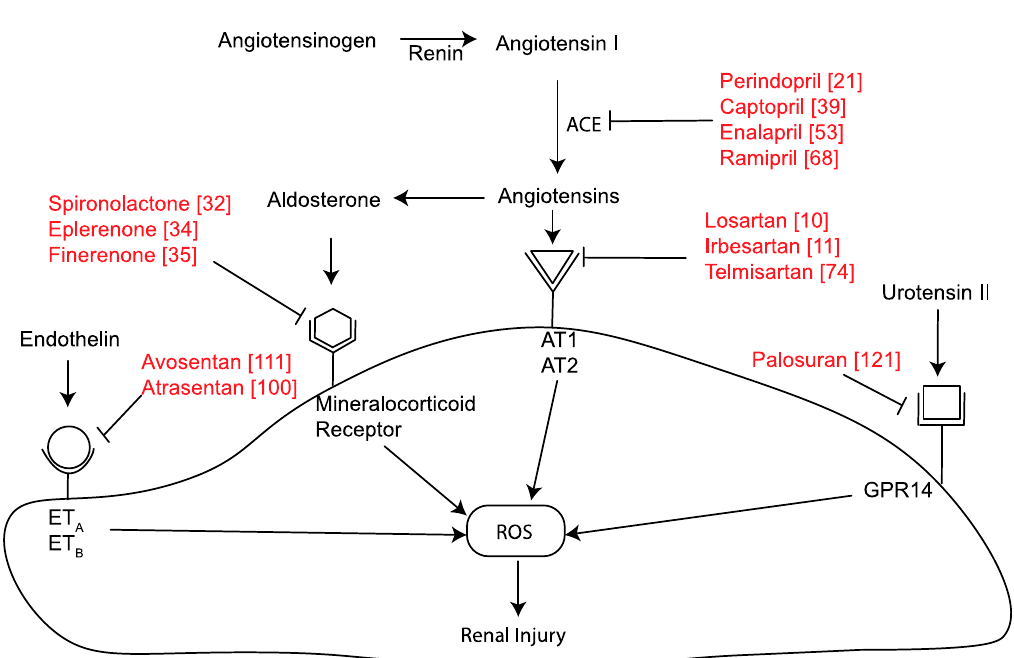
Figure 1. Role of vasoactive hormone pathways and relevant inhibitors in modulating renal injury via an effect on reactive oxygen species (ROS) [10,11,21,32,34,35,39,53,68,74,100,111,121].